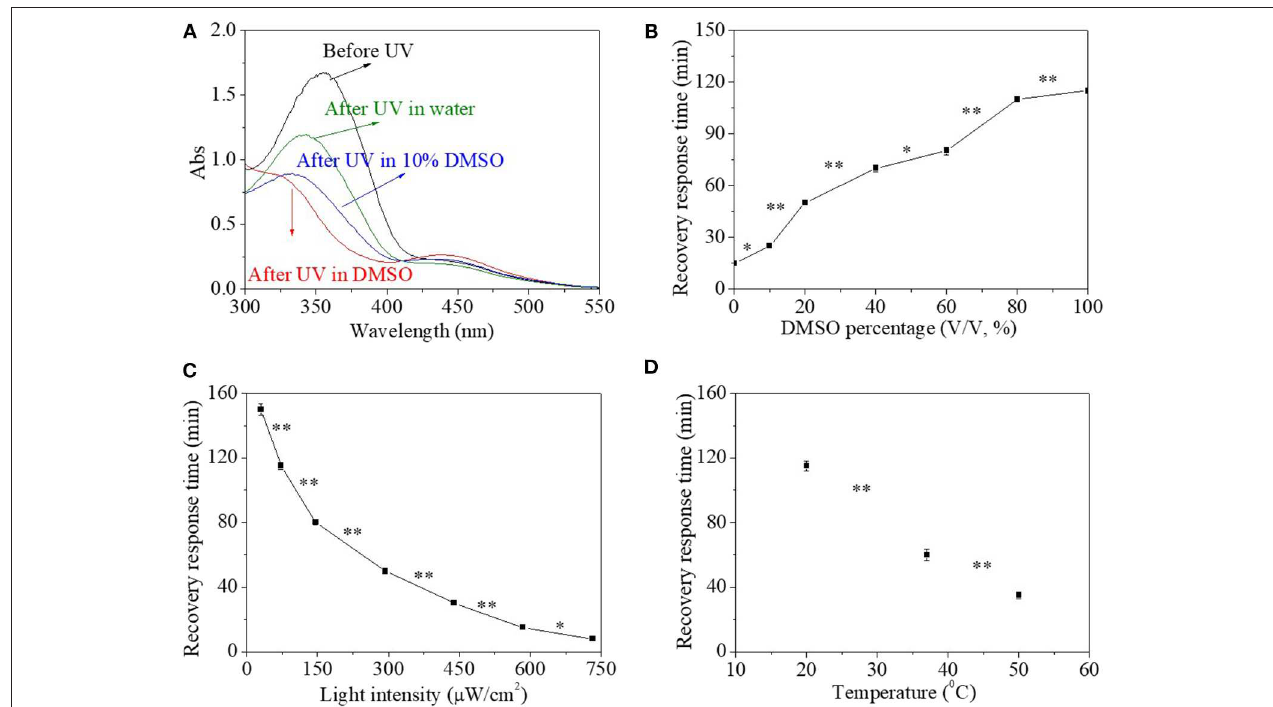
FIGURE 5 | (A) UV spectra of the HEMA-NVP-AZO terpolymer before and after UV irradiation in dimethylsulfone (DMSO)/H 2 O solution. (B) The recovery–response time in DMSO/H 2 O solution as a function of DMSO percentage under 73 µ W/cm 2 white light at 20 ◦ C. The recovery–response time as a function of (C) light intensity at 20 ◦ C and (D) temperature under 73 µ W/cm 2 white light in DMSO solution. * p < 0.05, ** p < 0.01. p refers to significance level in the data set.